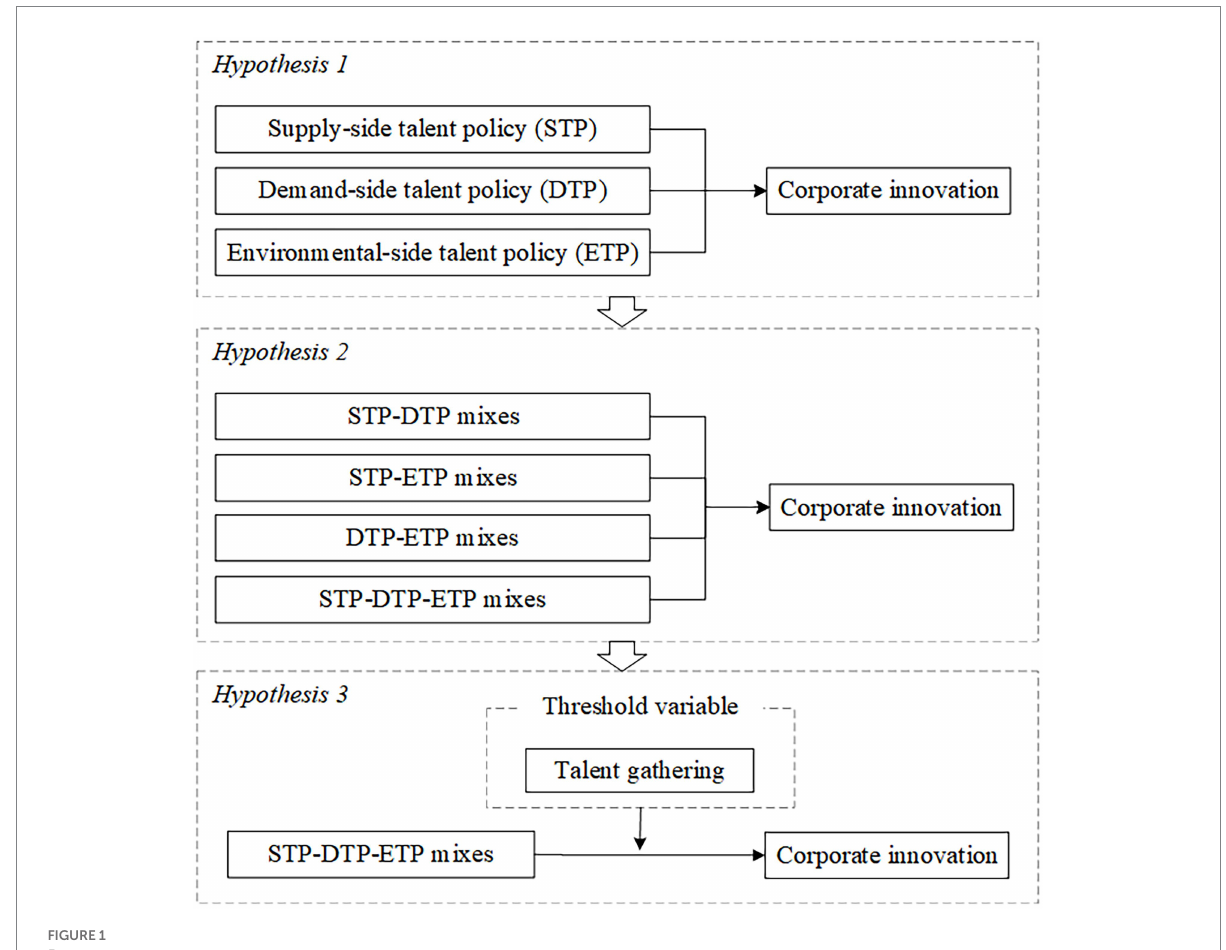
FIGURE 1 Process